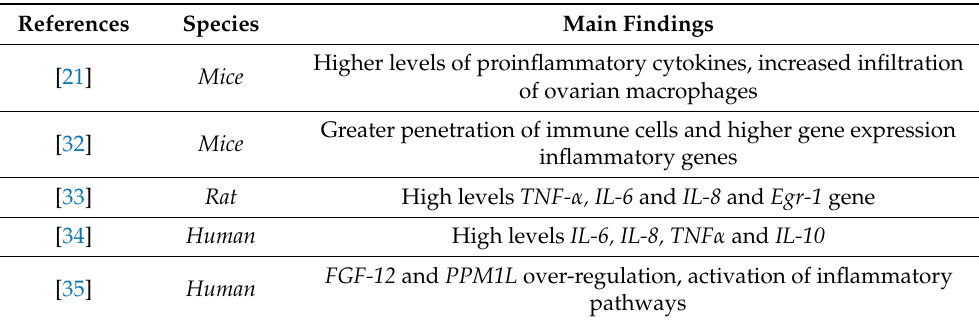
Table 2. A summary table of the main findings related to the impact of high-fat diet on inflammation pathways in